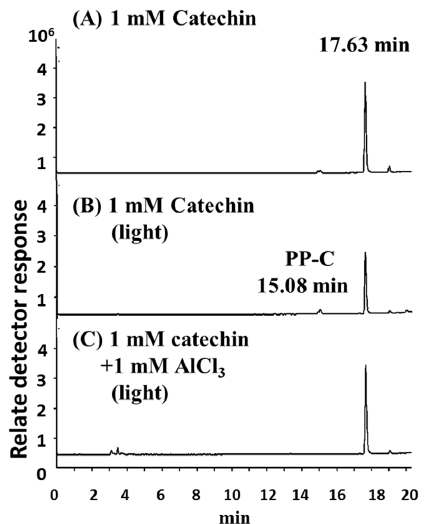
Figure 4. Total ion chromatograms of HPLC–MS analyses of ( A ) 1 mM catechin in the dark and 1 mM catechin in the absence ( B ) or presence ( C ) of 1 mM AlCl 3 treated with BLI at 20 W / m 2 for 120 min at pH 8. PP-C: The photoreaction product from the catechin.